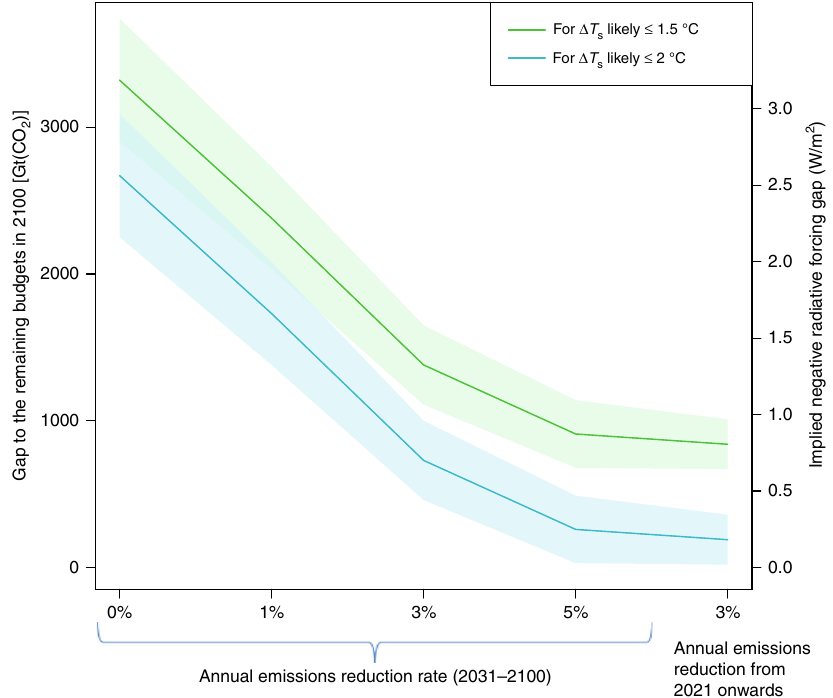
Fig. 2 Gaps to the Paris Agreement temperature goals. The emissions gaps [Gt(CO 2 )] between computed cumulative CO 2 emissions between 2015 and 2100 and the remaining budgets to the cumulative emissions amounts that keep Δ (cid:1) T below 1.5 °C (green line) and 2 °C (blue line) with a 66% likelihood s are shown for several scenarios. The remaining budgets are based on data from an IPCC analysis of model ensemble output 3 , yielding 650 ± 130 Gt(CO 2 ) to 1.5 °C and 1300 ± 130 Gt(CO 2 ) to 2 °C. The fi rst four scenarios are based on ful fi lment of the Paris Agreement NDCs by 2030 and various rates of annual emissions reductions thereafter. The last scenario is for an annual emissions reduction rate of 3%/yr starting already in 2021. The shading represents the lower and upper bound values computed for each temperature goal, and the solid line is the mean of these. The right side axis shows the implied negative radiative forcing [W/m 2 ] associated with the CO 2 budget gap values, using a conversion factor of 9.6 x 10 – 4 (W/m 2 )/(Gt(CO 2 ). For further information and computations, see Methods and Supplementary Table